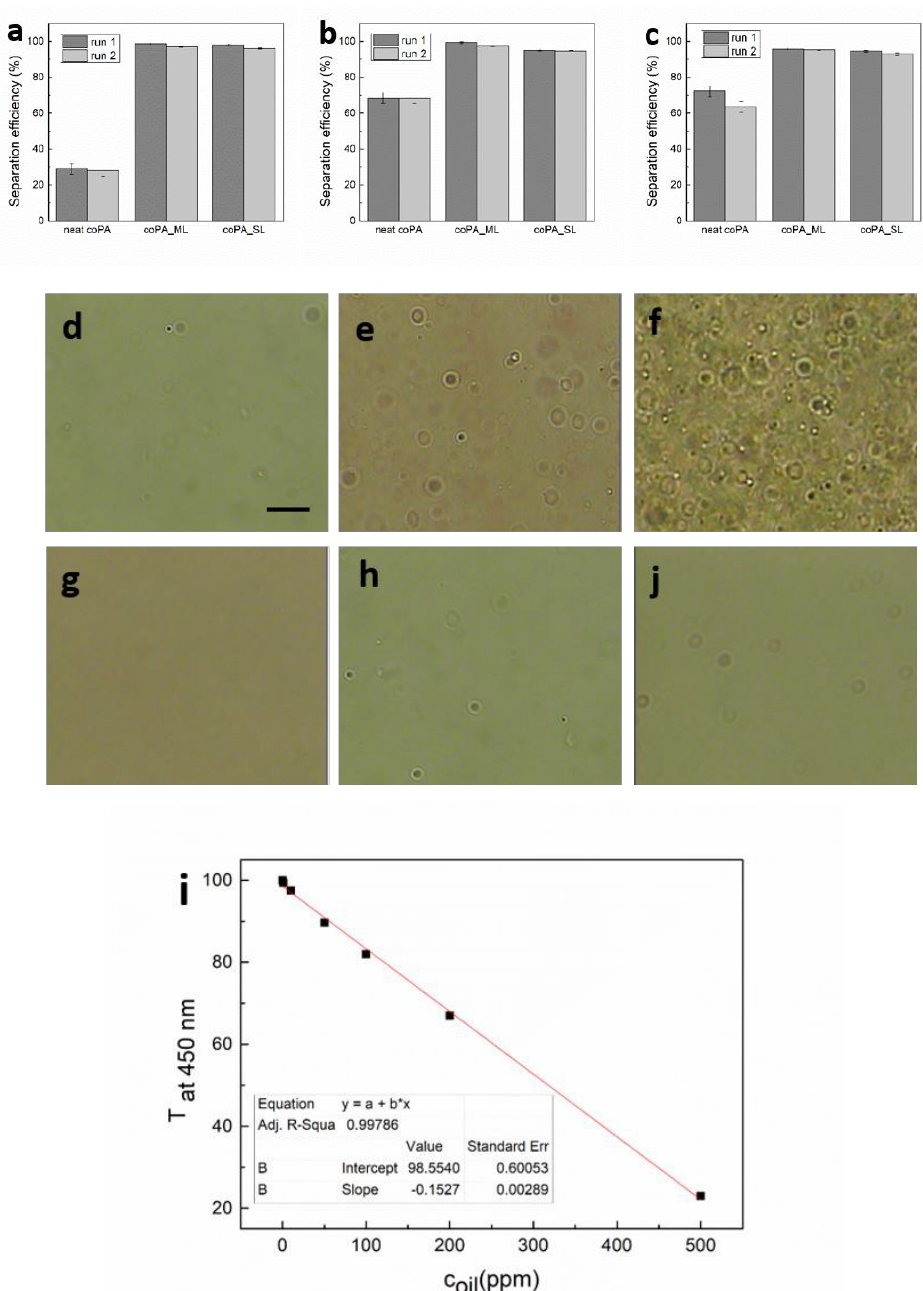
Figure 8. UV spectroscopy of filtrates obtained after separation of ( a ) 10, ( b ) 100, and ( c ) 1000 ppm vegetable oil in water through a neat coPA mat and the coPA covered with ML- and SL-Ti 3 C 2 T x at constant pressure of 0.5 bar. Optical microscopy images of ( d ) 10 ppm emulsion, ( e ) 100 ppm emulsion, ( f ) 1000 ppm emulsion, ( g ) permeate of 10 ppm emulsion, ( h ) permeate of 100 ppm emulsion, and ( j ) permeate of 1000 ppm emulsion. Bar is 1 µ m. ( i ) Calibration fit for various concentration of vegetable oil emulsions at transmittance of λ = 450 nm.